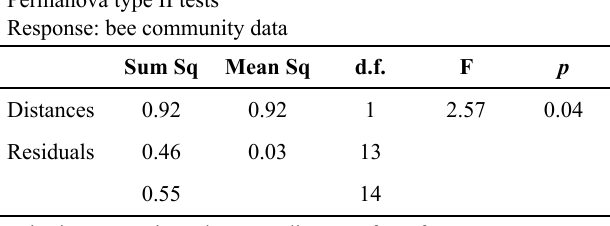
Table 2 . Cumulative contributions of bee community to different sets of distances from forest fragments around canola ( Brassica napus ) fields in Southern